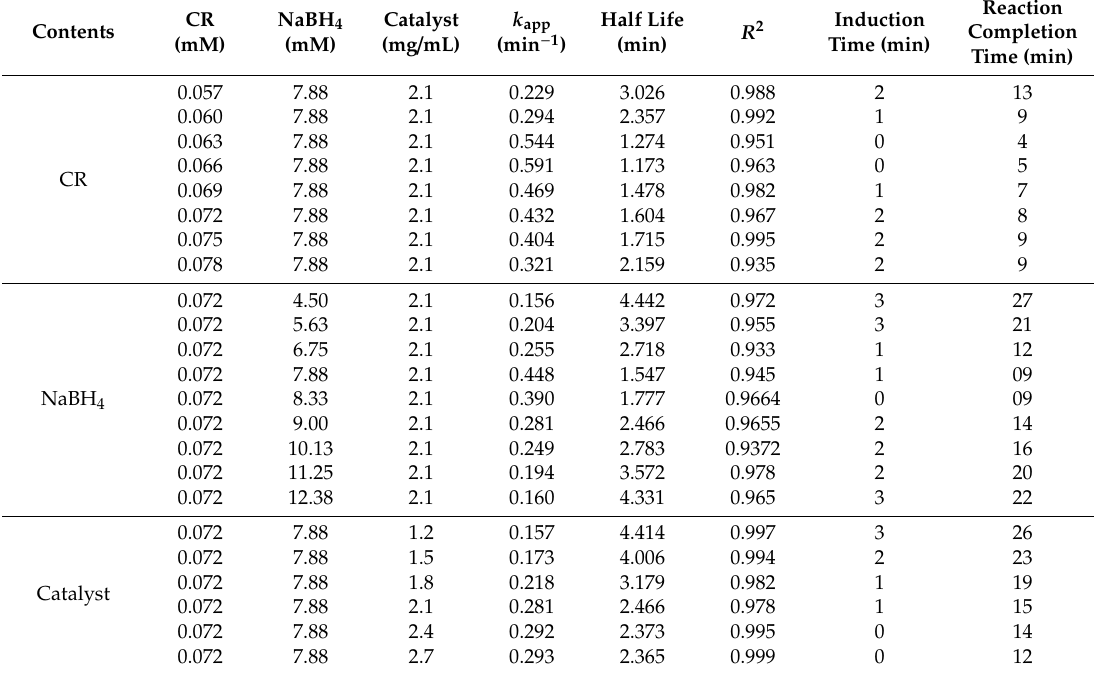
Table 2. E ff ect of CR, NaBH 4 and catalyst contents for reduction of CR using biogenic CAg-nPs catalyst at ambient